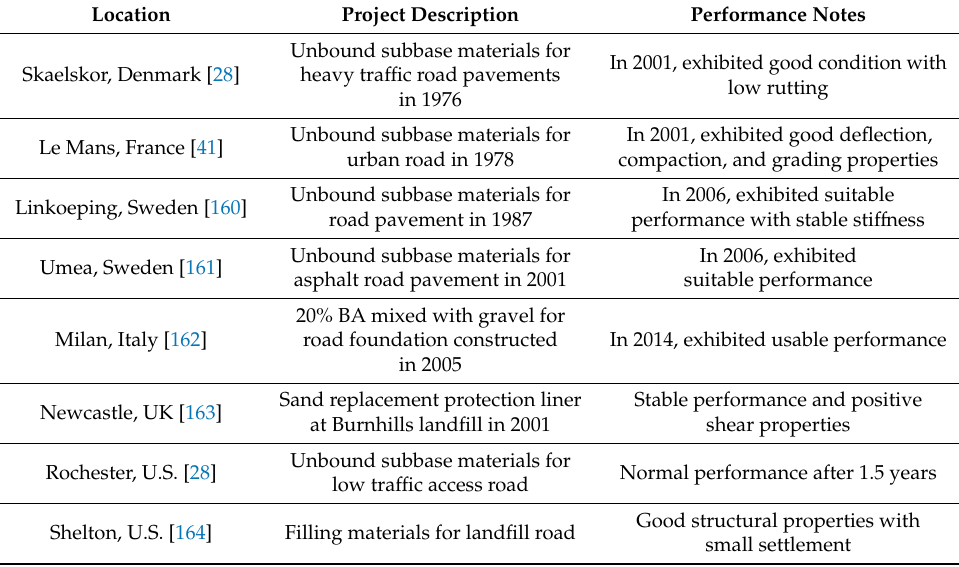
Table 6. Field applications of MSWI BA as a geomaterial and performance